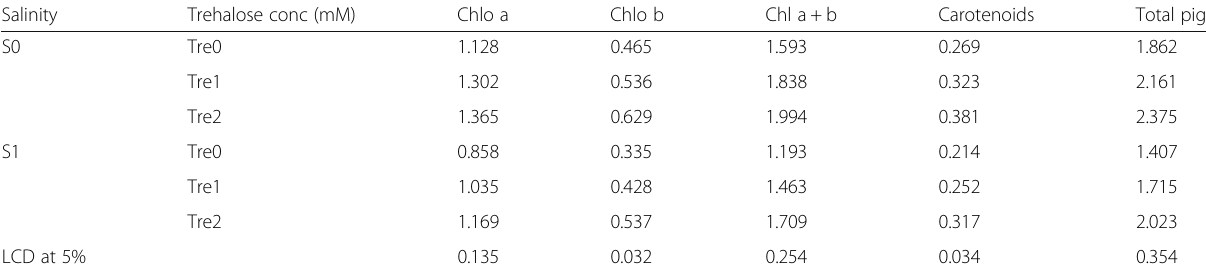
Table 3 Effect of trehalose at 0 mM (Tre 0), 10 mM (Tre 1), and 50 mM (Tre 2) on photosynthetic pigments (mg/g fresh wt) of wheat plants irrigated with tap water (S0) or diluted sea water at 6.25 dS/m (S1). Results are means of two successive seasons Salinity